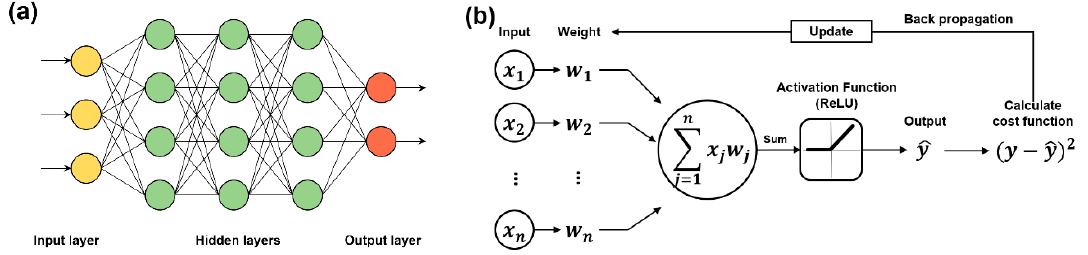
Figure 4. Description of deep neural network (DNN) model: ( a ) Typical structure of DNN model; ( b ) principle of value prediction using DNN model.